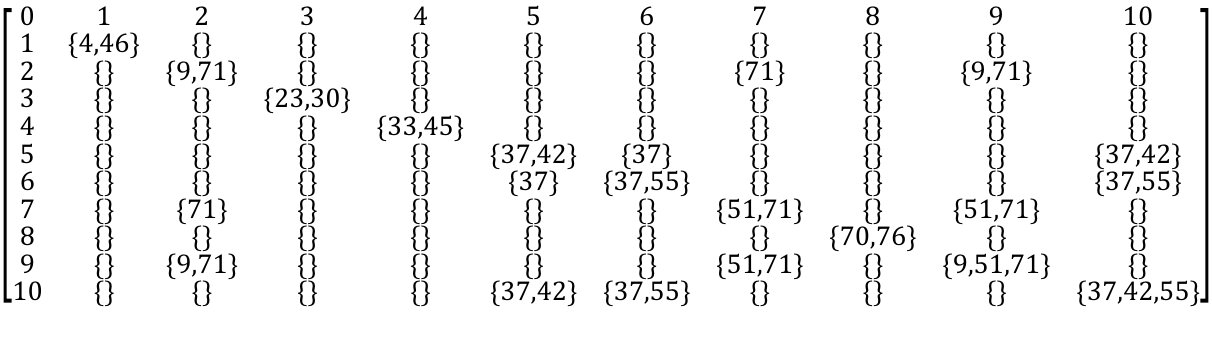
Table 6. Diagram of representation of the intersection among the emerged circuits for the simulation takes as example.